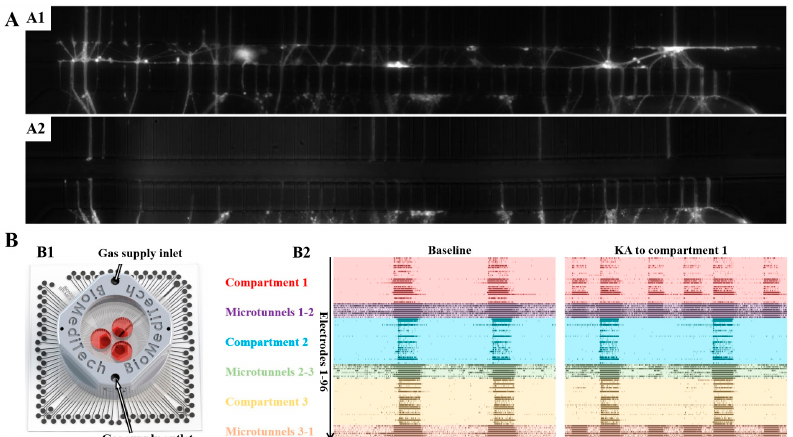
Figure 7. Application of neural chip platform-integrated microfluidics and microelectrode Arrays in neurological diseases. ( A ) Fluorescent images before and after axonal injury and the growth of axons before and after axotomy, (A1) and (A2) [151]. Reproduced with permission from Van de Wijdeven, Biosensors and Bioelectronics; published by Elsevier, 2019. ( B ) Building of an in vitro epilepsy model using KA to induce electrophysiological signals (B2) of neurons before and after epileptiform discharges on the neural chip (B1) [154]. Reproduced with permission from Pelkonen, Biosensors and Bioelectronics; published by Elsevier, 2020.